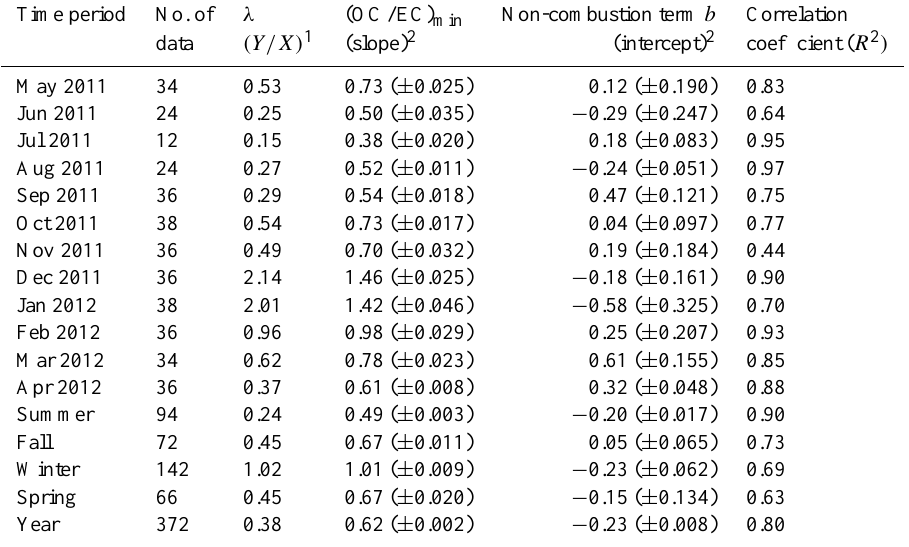
Table 1. Deming regression results of (OC/EC) min (the slope) and non-combustion term b (the intercept) using the lowest 5% data by OC-to-EC ratio on a monthly, seasonal and annual basis from the 1-year carbon measurements at MK